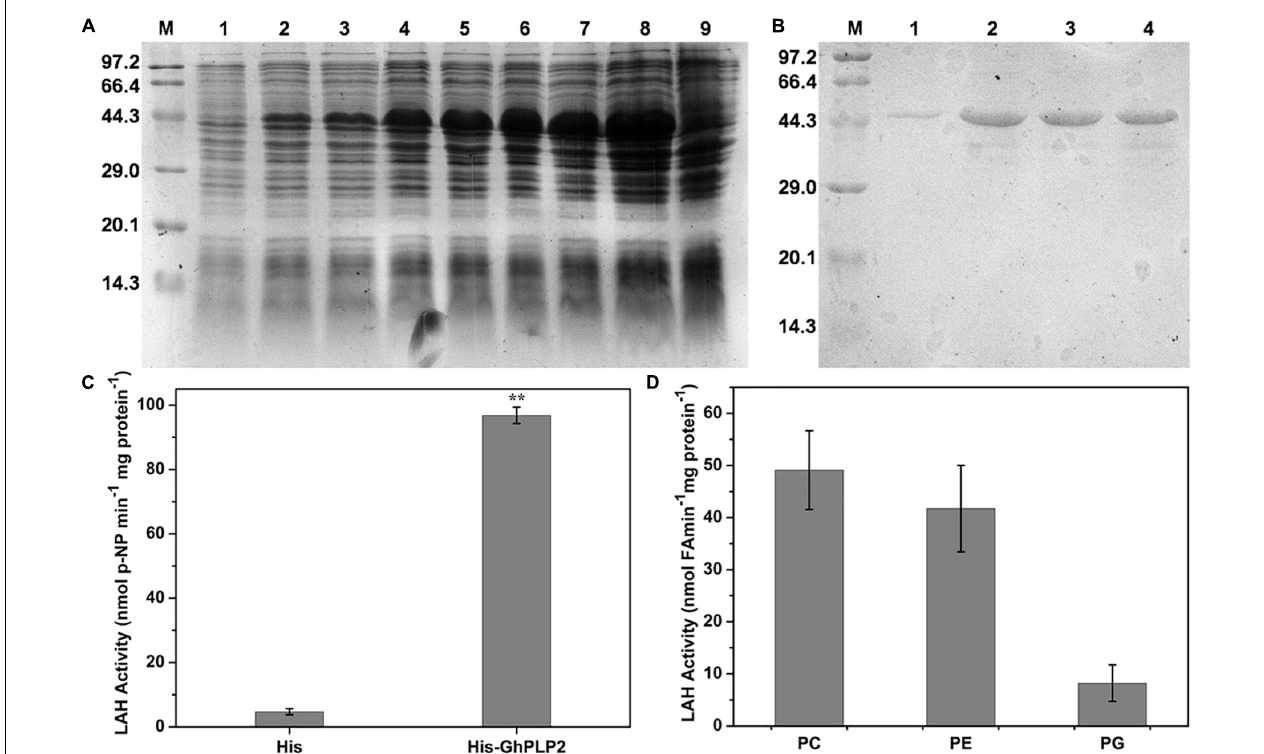
FIGURE 2 | Induction and purification of the His-GhPLP2 protein and the LAH activity assay. (A) Proteins from induced bacteria were analyzed by SDS-PAGE. M: molecular mass of markers (kDa); 1: uninduced crude bacterial proteins; 2–8: IPTG-induced crude bacterial proteins at 22 ◦ C with different time points (1, 2, 4, 6, 12, 16, and 24 h); 9: pET-22b empty vector was induced at 24 h. (B) GhPLP2 fusion proteins purified on a Ni-column. 1–4: a series of eluted proteins. (C) p-nitrophenol (NP) was liberated from p-nitrophenyl palmitate by the LAH activity of GhPLP2 protein. Asterisks indicate a significant difference compared with the empty vector control ( **P < 0.01, Student’s t -test). (D) Fatty acids were released by the activity of LAH from the GhPLP2 protein when PC, PE, and PG were used as substrates. Data were obtained from three independent biological replicates and presented as the mean ± standard